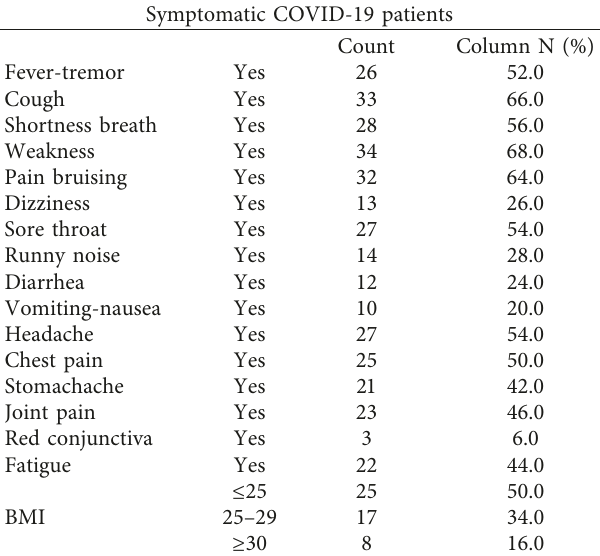
Table 3: Different signs and features of symptomatic COVID-19